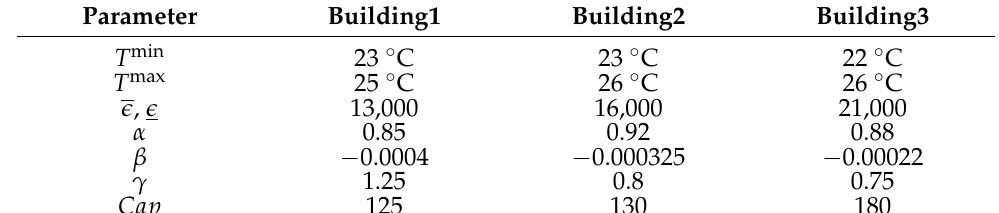
Table 1. Simulation parameters in the three buildings.